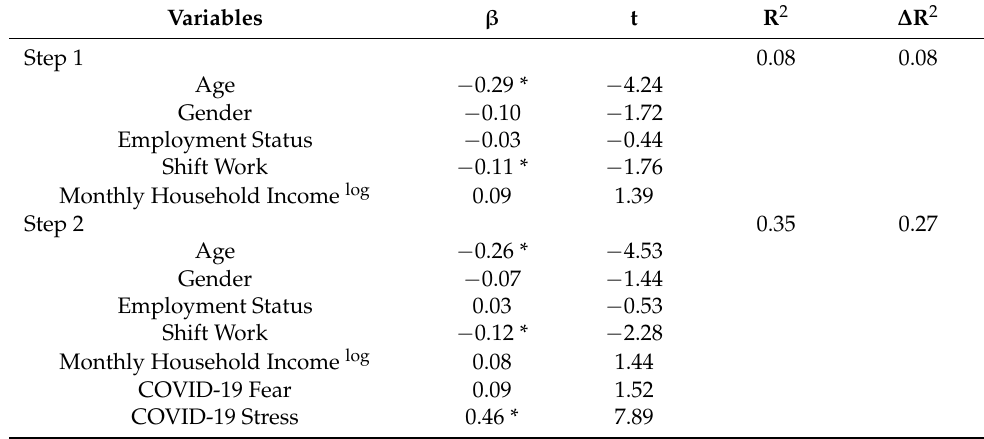
Table 3. Summary of hierarchical multiple regressions predicting depression from sociodemographic and occupational